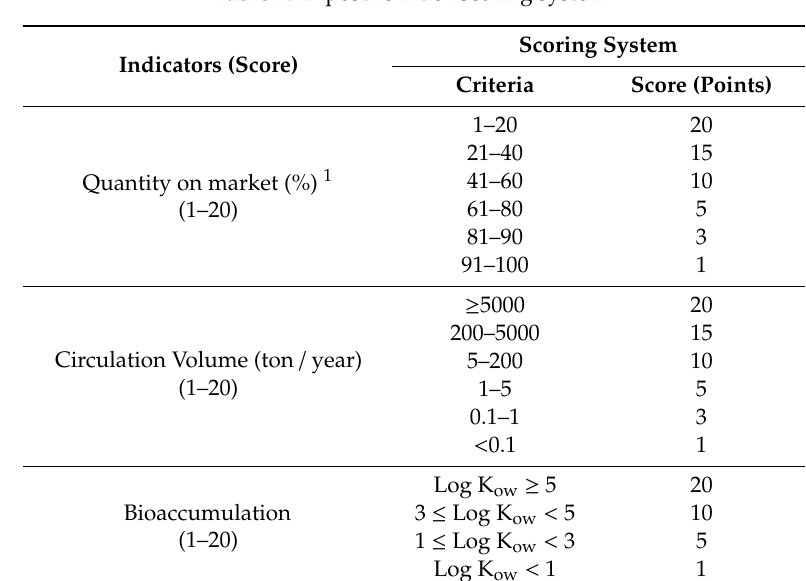
Table 1. Exposure index scoring